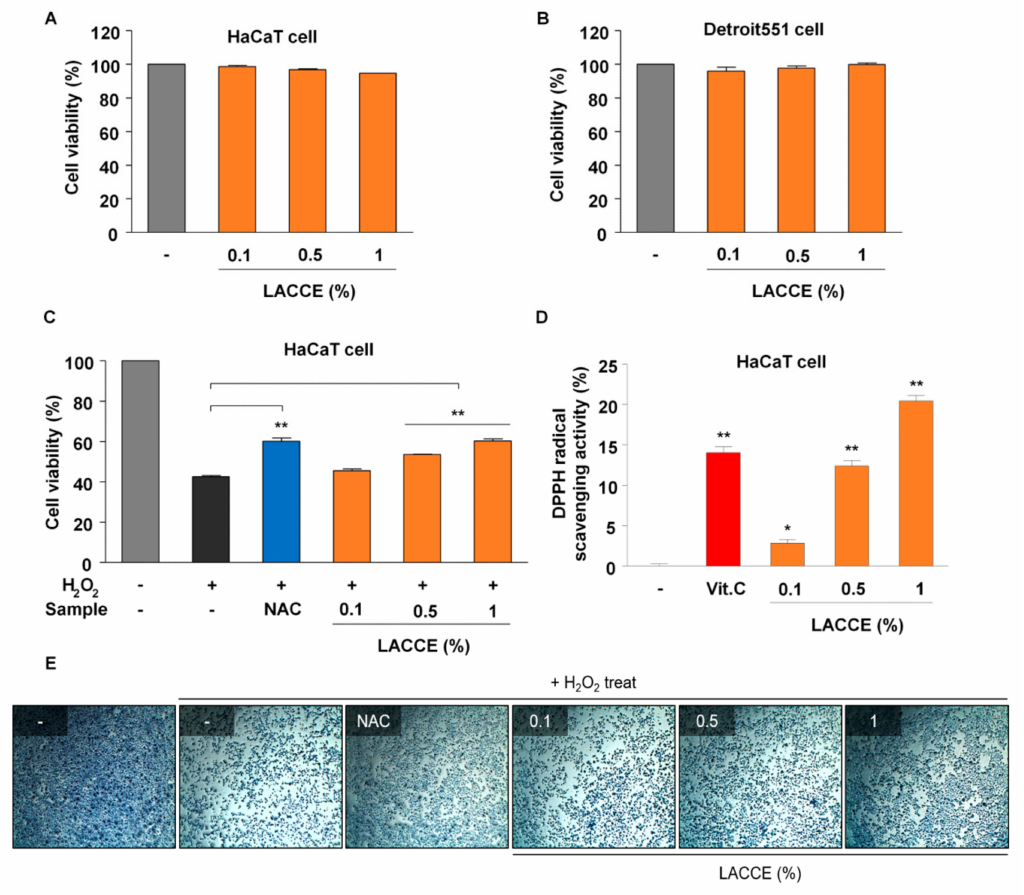
Figure 2. In vitro assessment of LACCE as an anti-aging agent, including cytotoxicity and anti-oxidant activity. Cell viability for three di ff erent concentrations (0.1%, 0.5%, and 1%) of LACCE in HaCaT cells ( A ) and Detroit551 cells ( B ) by MTT assay. Gray bar indicates cells treated with distilled water. ( C ) HaCaT cells were treated with hydrogen peroxide. Cell viability for three di ff erent LACCE concentrations was measured by 3-(4,5-dimethylthiazol-2-yl)-2,5-diphenyl tetrazolium bromide (MTT) assay. N-acetyl cysteine (NAC) was used as a positive control. ( D ) Antioxidant activity of di ff erent LACCE concentrations was measured by DPPH assay. Vitamin C (Vit. C) was used as a positive control. * and ** indicate statistical significance with p -values of less than 0.05 and 0.01, respectively. ( E ) Cell morphology in each sample treated with hydrogen peroxide was visualized with methylene blue